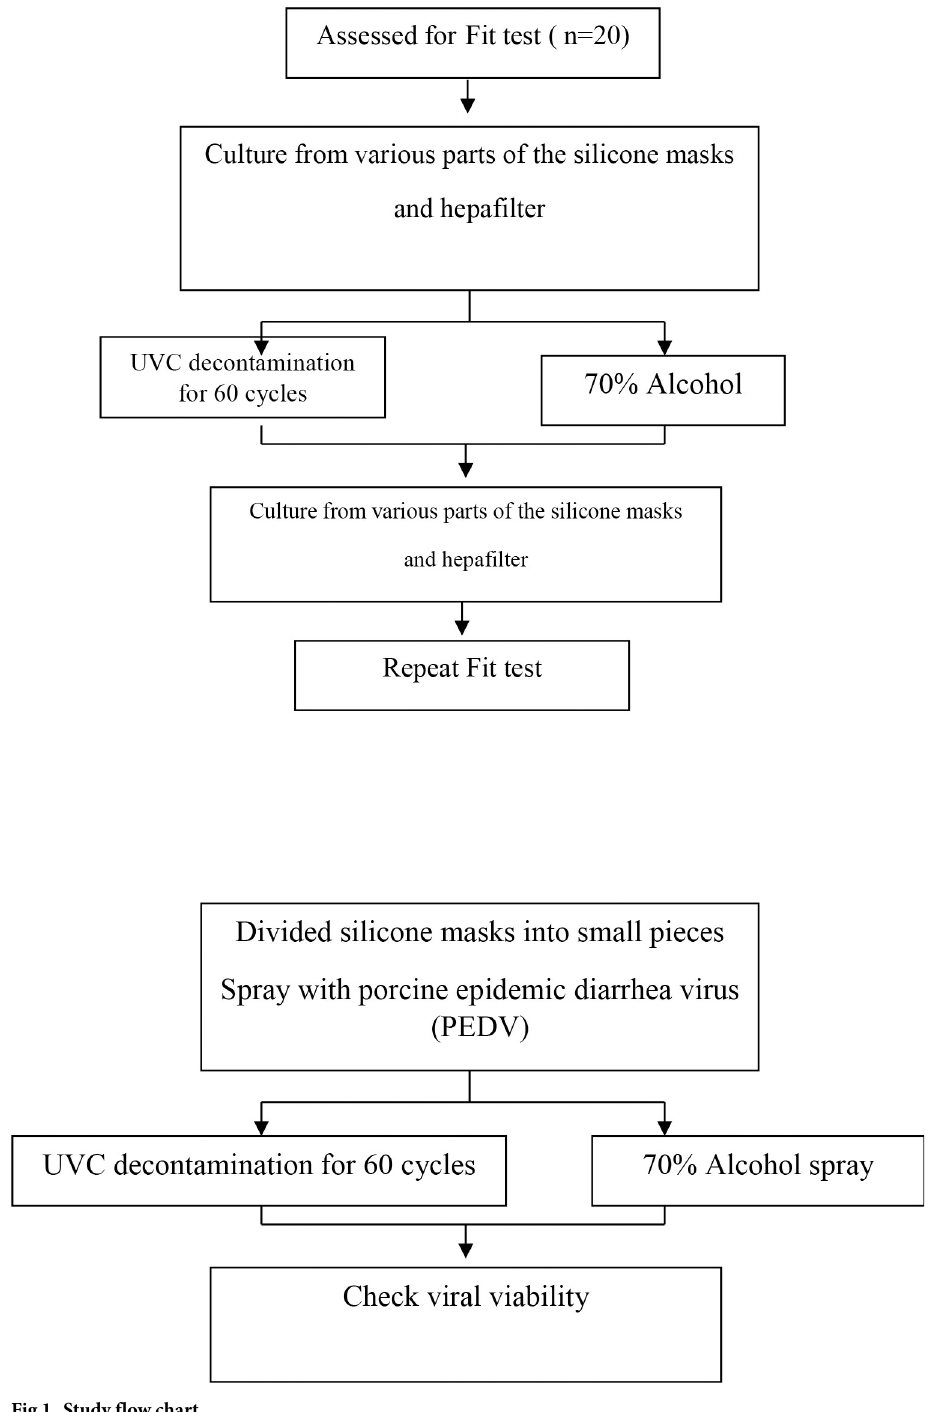
Fig 1. Study flow